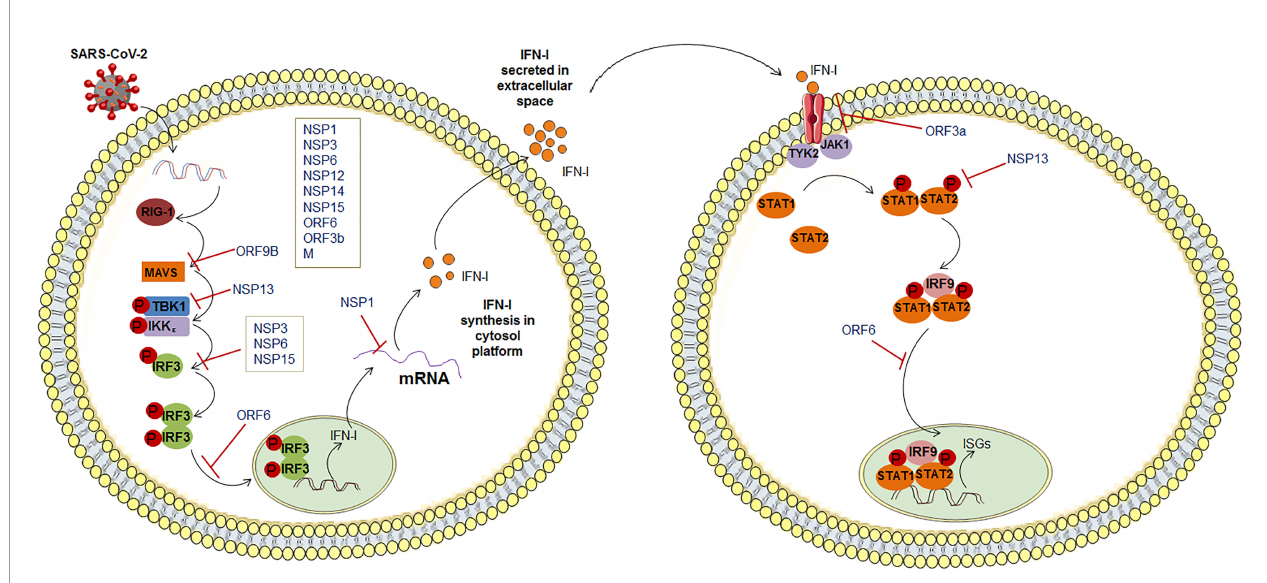
FIGURE 2 | SARS-CoV-2 innate immune evasion by interfering with the IFN signaling